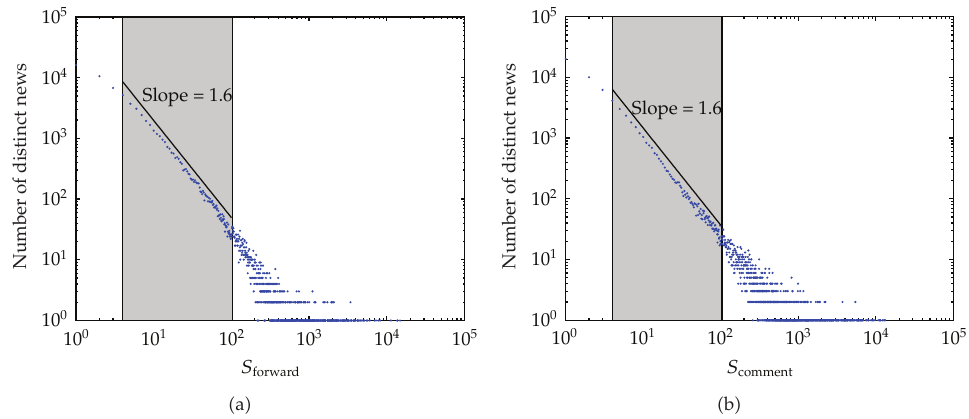
Figure 2: (cid:6) a (cid:7) The strength of forwarding S forward . (cid:6) b (cid:7) The strength of comment S comment . From the